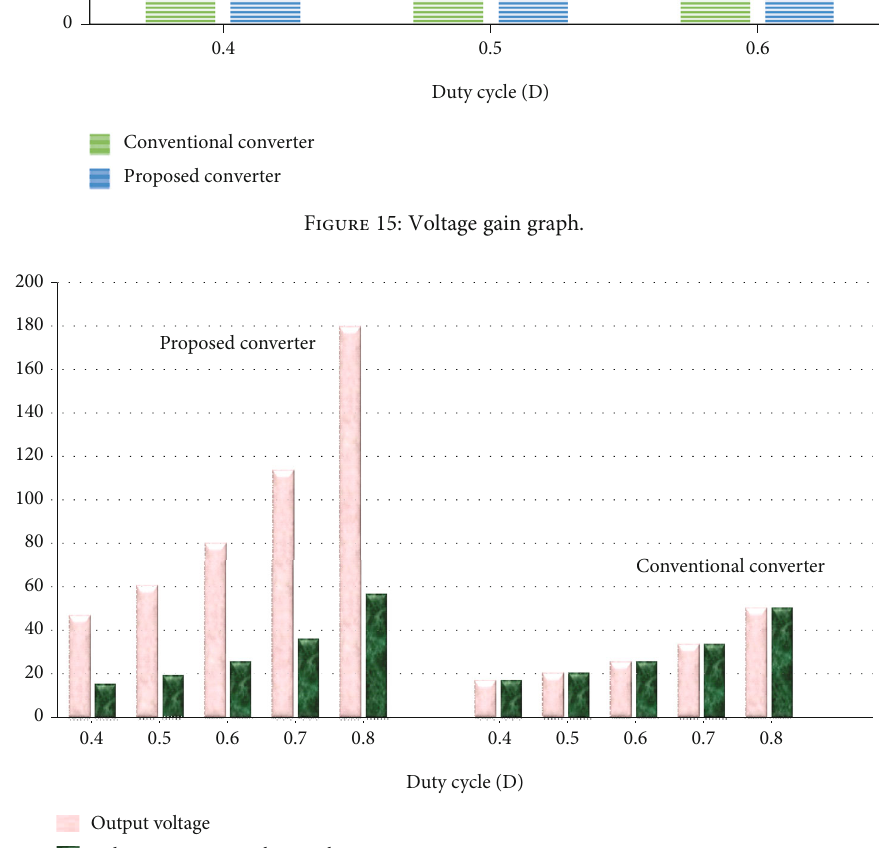
Figure 16: Switching stress